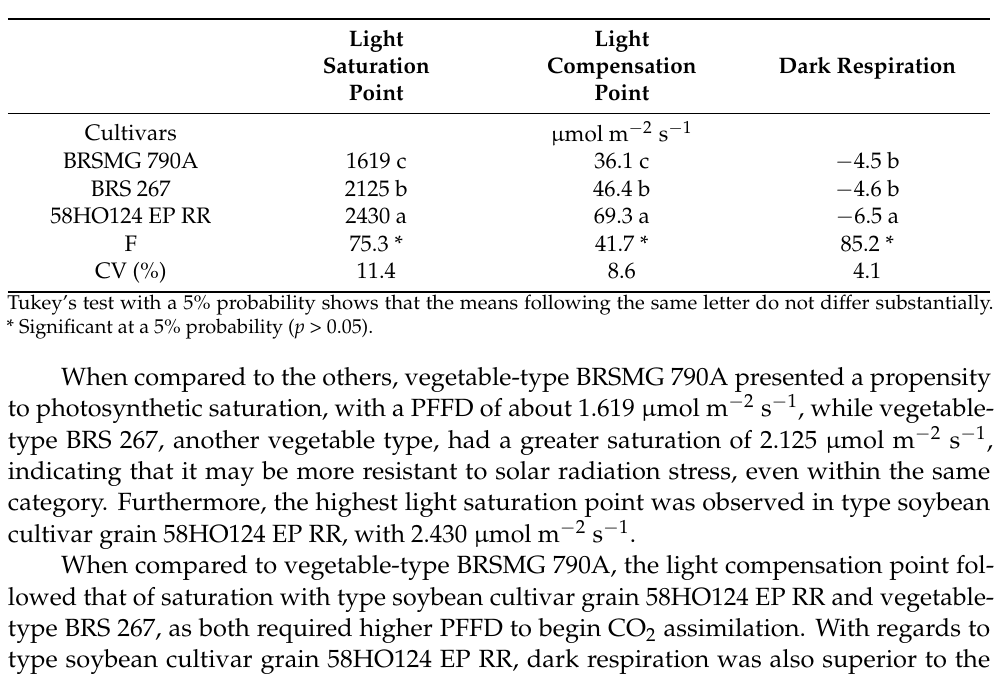
Figure 3. Net CO 2 assimilation rate ( A , µ mol m − 2 s − 1 ) as a function of photosynthetic photon flux density (PPFD, µ mol m − 2 s − 1 ) of vegetable and type soybean cultivar grain. Botucatu, SP, Brazil, 2021. Table 3. Light compensation point ( µ mol m − 2 s − 1 ), light saturation point ( µ mol m − 2 s − 1 ), and dark respiration ( µ mol m − 2 s − 1 ) of vegetable and type soybean cultivar grain soybean cultivars. Botucatu, SP, Brazil,